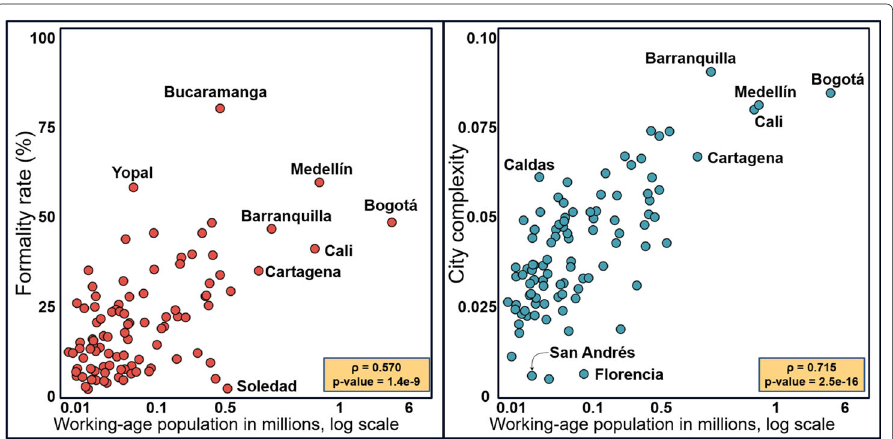
Fig. 5 The left panel shows the relationship between formality rate and working-age population of the city (log scale). The Pearson’s correlation coefficient between formality rate and (log) working-age population is ρ = 0.57. The right panel shows the relationship between city complexity and working-age population (log scale). The Pearson’s correlation coefficient between city complexity and (log) working-age population is ρ = 0.715. In both cases, the city definition corresponds to τ = 0, i.e., when no municipalities are